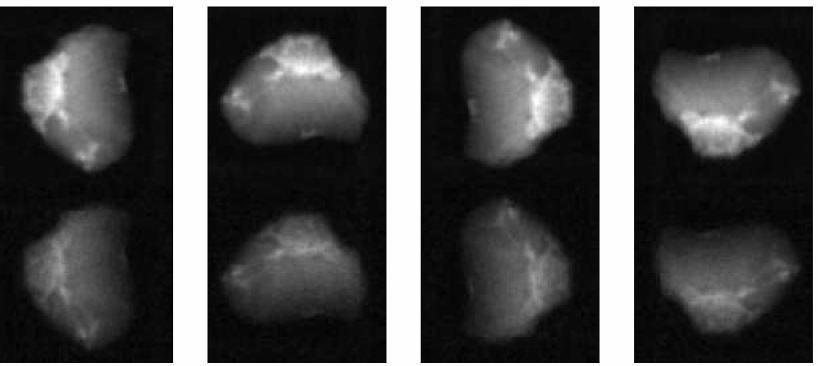
Figure 1. An example of four two-layer X-ray images prepared for analysis based on low- and high-energy scans of a single ore grain.